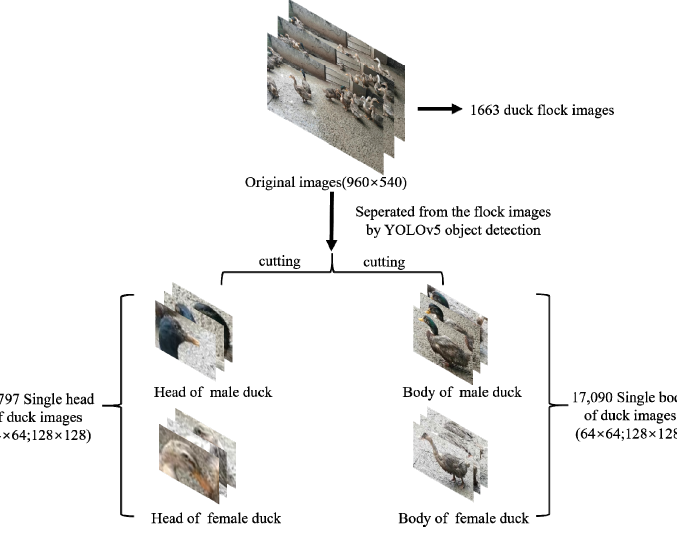
Figure 3. The original dataset consists of 1663 duck group images. The classification dataset of single duck images is extracted after Yolov5 target detection. duck images is extracted after Yolov5 target